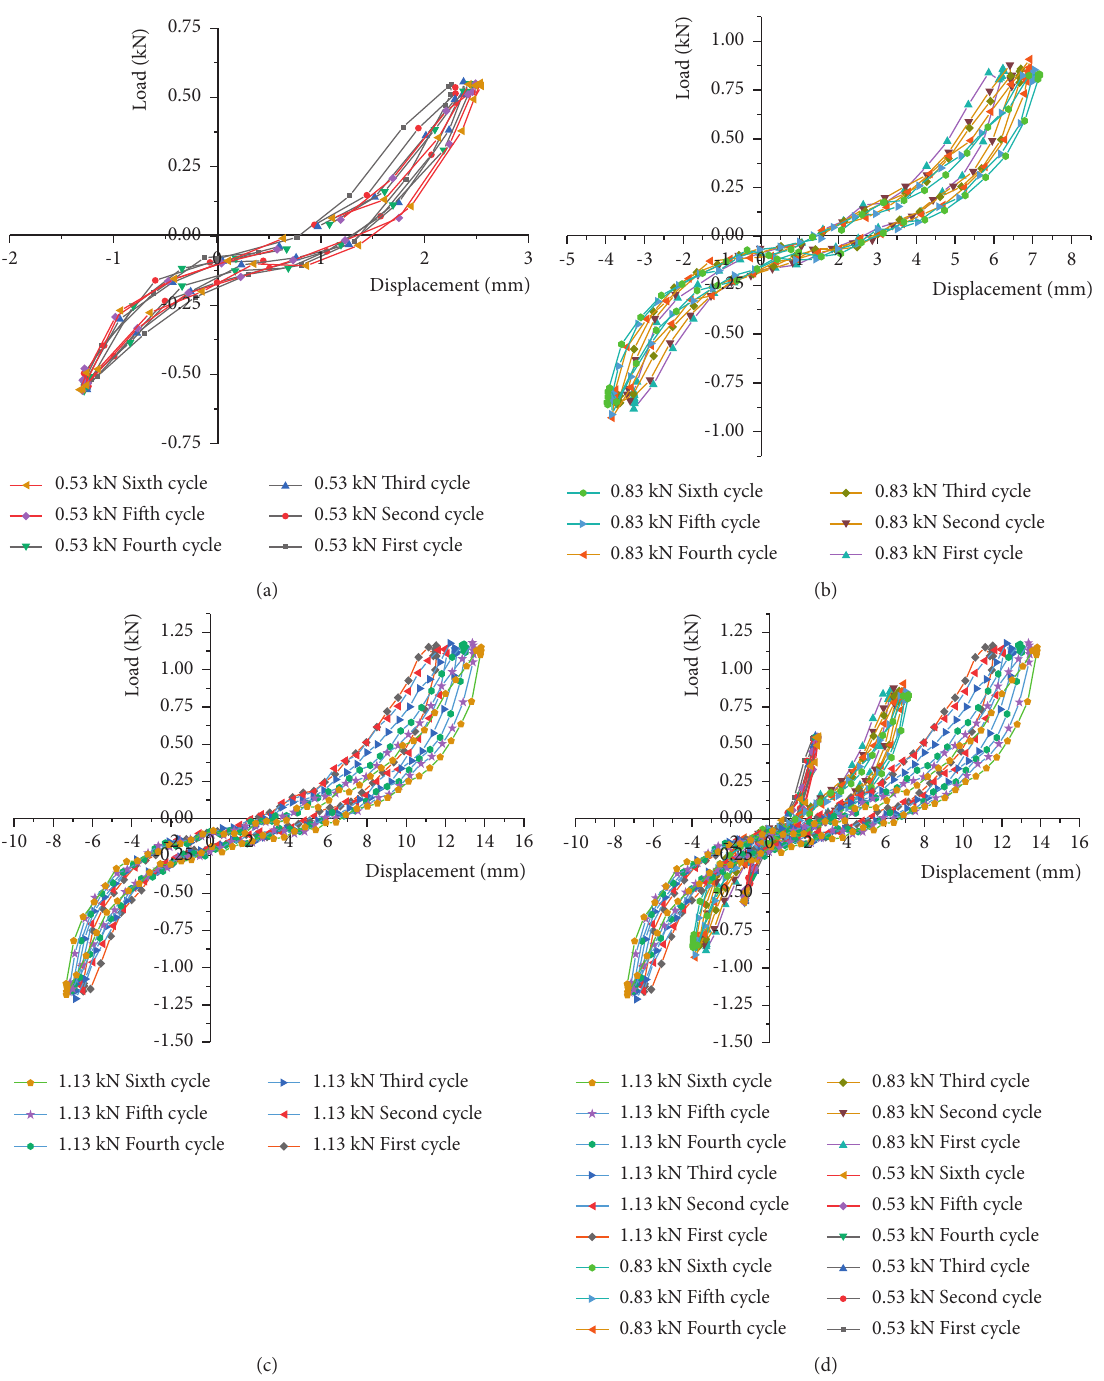
Figure 14: Influence of cycle number on hysteretic cycle shape under different load levels. (a) ± 0.53kN. (b) ± 0.83kN. (c) ± 1.13 kN. (d) View the situation as a